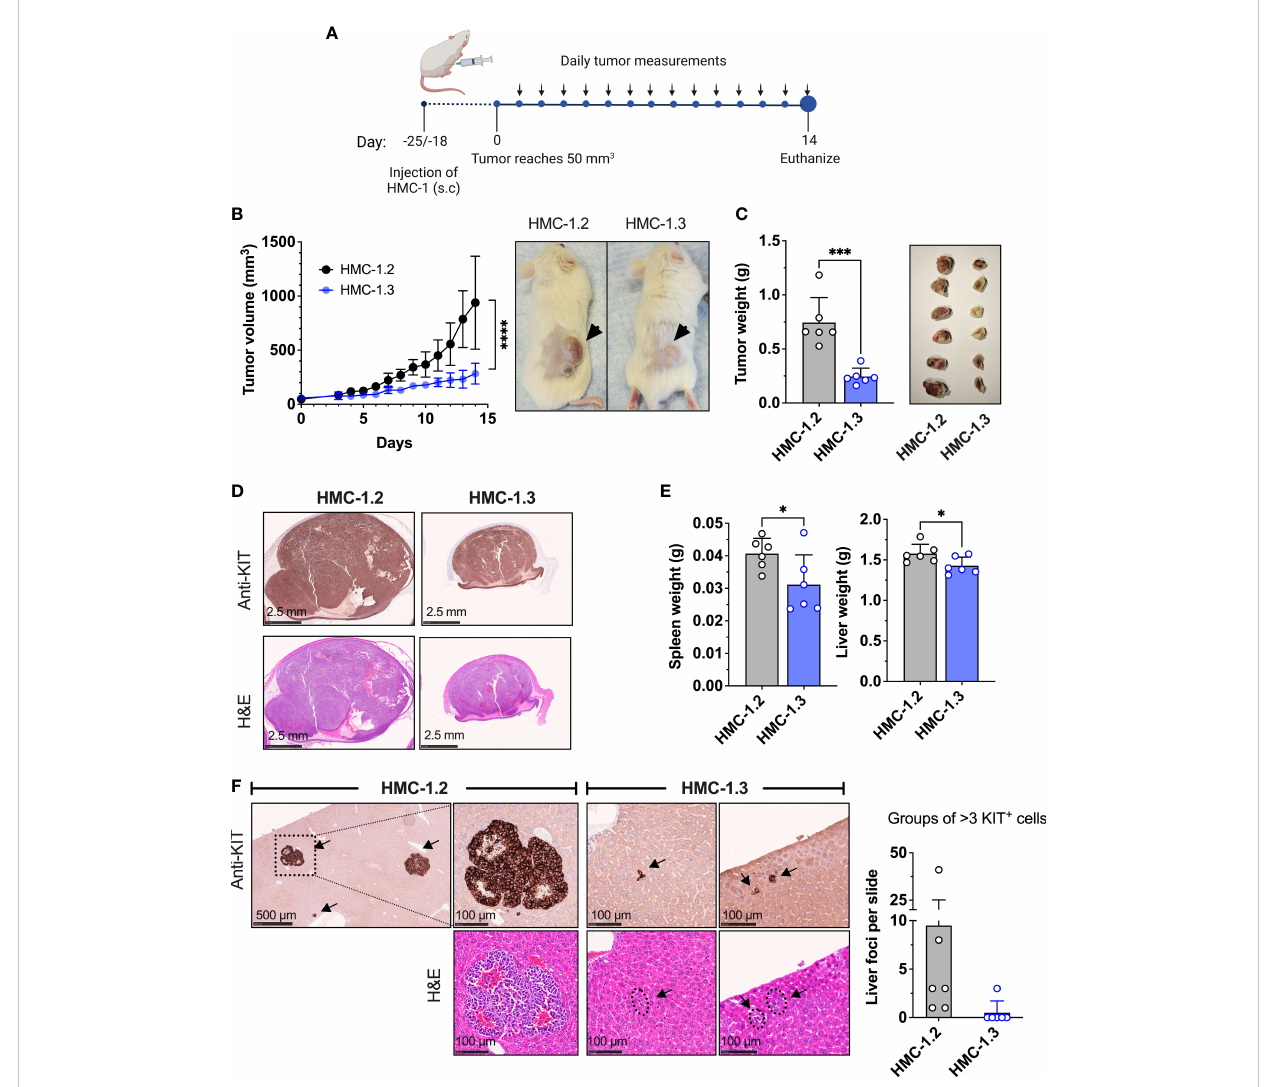
FIGURE 4 Repair of the V560G-KIT mutation in HMC-1.2 results in diminished tumor growth and metastasis. (A) Illustration of the xenograft protocol. Mice (6 per group) were injected with 1 × 10 6 HMC-1.2 or HMC 1.3 cells (shown is the 1H9 subclone; similar results were obtained using the other subclone 2E2) into the right fl ank subcutaneously. Once the tumor volume reached 50 mm 3 (usually 18-25 days after injection), measurements were performed daily using a caliper. On day 14, mice were euthanized for tissue collection. This illustration was created using Biorender (biorender.com) (agreement number BT24ABIPLB). (B) Tumor volume measurements on live mice over time. ****p<0.0001 between curves using a two-way ANOVA test. Representative images of the appearance of tumors at endpoint in mice injected with either HMC-1.2 or HMC-1.3 cells. (C) Weight of tumors excised on day 14 from mice injected with either HMC-1.2 or HMC-1.3 cells. The images on the right are all fi xed tumors collected in this experiment. (D) Histology slides of excised tumors from mice injected with HMC-1.2 and HMC-1.3 stained with anti-KIT or H&E, as indicated. (E) Average of spleen and liver weights on day 14. (F) Representative images of well-formed foci in livers from mice injected with HMC-1.2 cells or groups of >3 KIT positive cells in livers of mice injected with HMC-1.3 cells (indicated by arrows). KIT immunostaining and H&E staining are shown as indicated. The graph represents the numbers of groups of > 3 cells or foci containing KIT-positive cells in the histological slides (each dot represents one mouse). Data represent Mean ± SD. *p<0.05; ***p<0.001 using unpaired